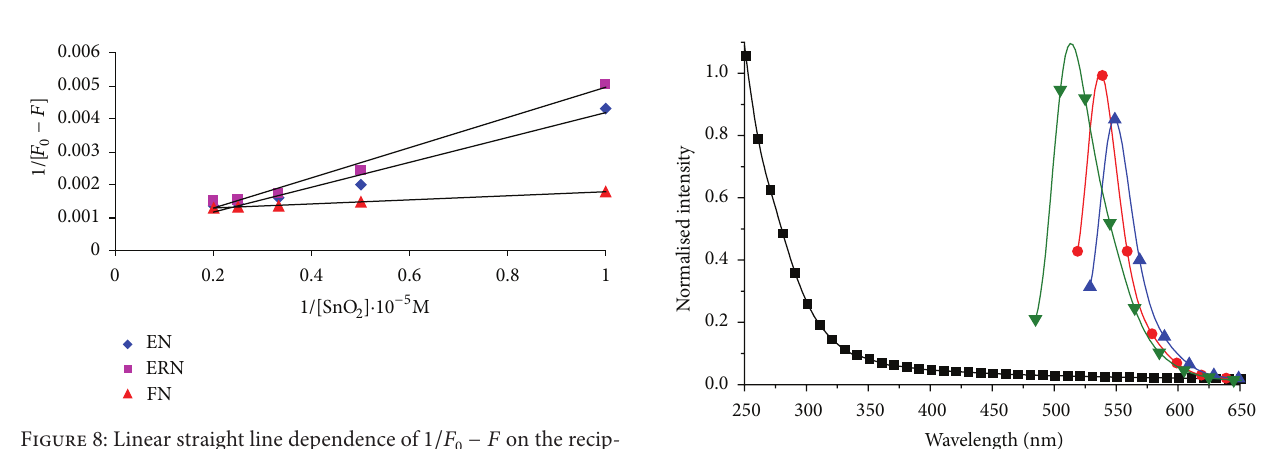
Figure 8: Linear straight line dependence of 1/𝐹 0 − 𝐹 on the recip- rocal concentration of colloidal SnO 2 .